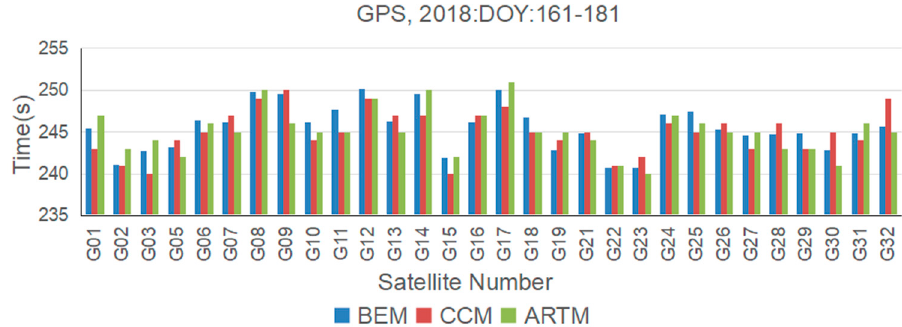
Figure 2. The mean shift time for GPS satellites calculated by the three methods during DOY: 161–181, 2018.